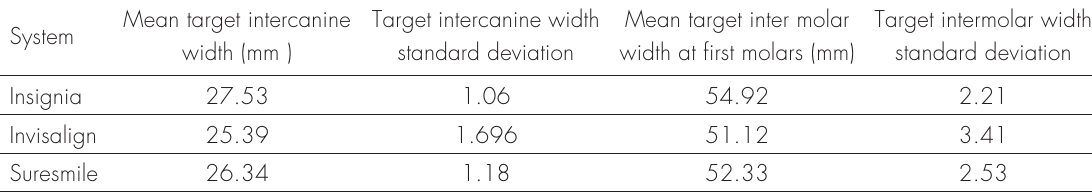
Table V. Intermolar and intercanine mean target width and SD by intervention.